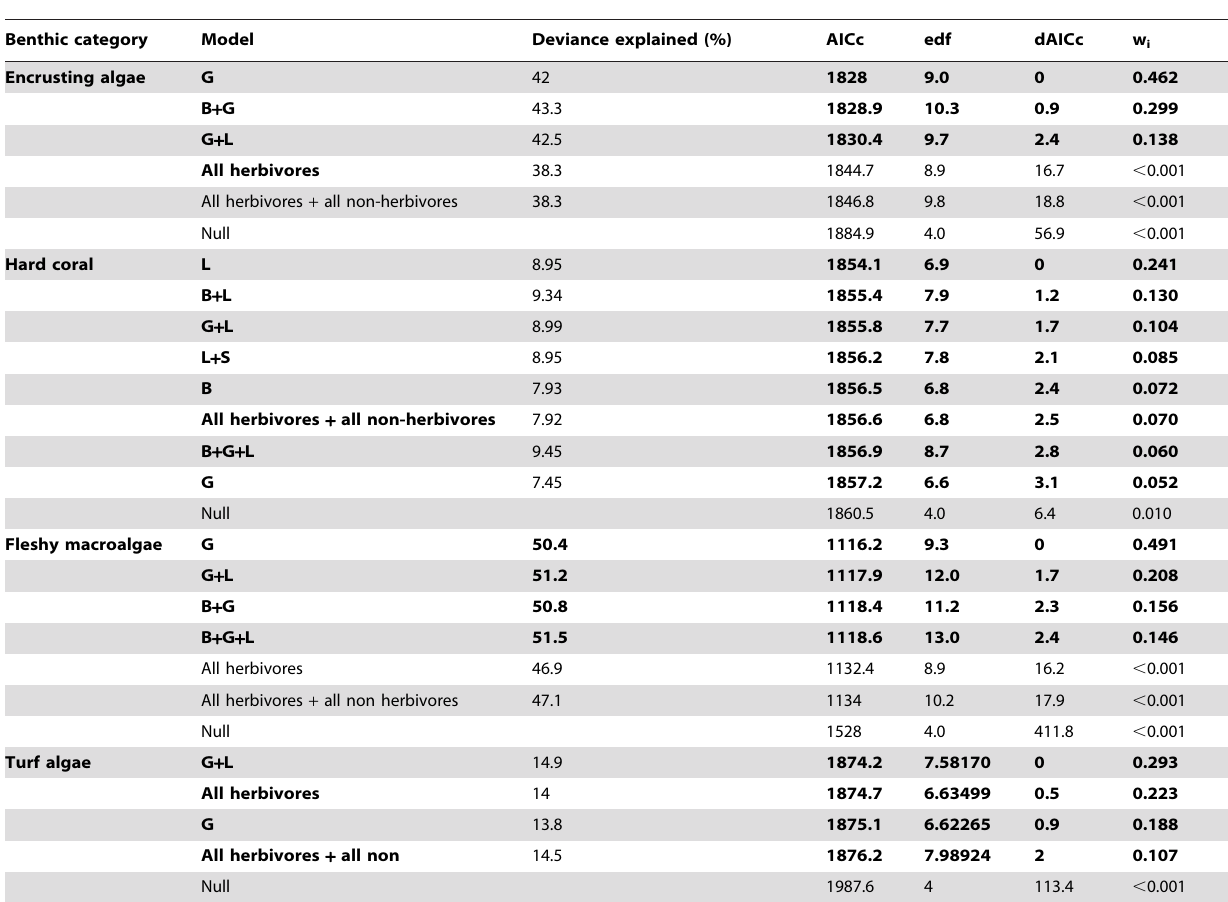
Table 1. Variance explained in benthic variables by herbivorous fish in American Samoa.